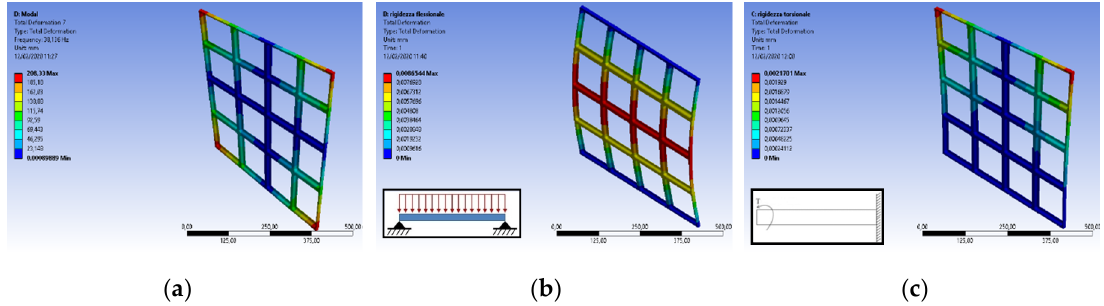
Figure 5. Numerical evaluation of ( a ) resonance frequency, ( b ) flexural and ( c ) torsional stiffness.